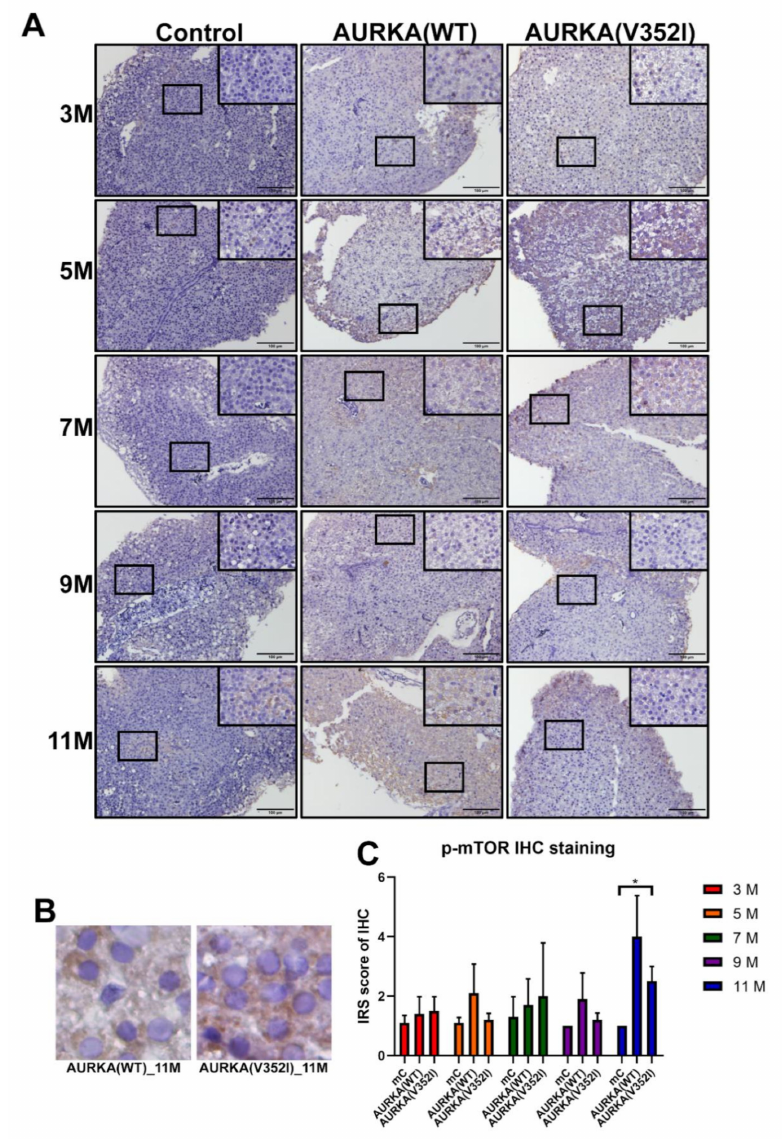
Figure 11. Immunoreactive score of phospho- mammalian target of the rapamycin (mTOR) (at Ser2448, inactive form) immunostaining for the AKT / mTOR pathway reveals that the expression of mTOR has no significant difference between control and AURKA transgenic fish. ( A ) Representative images of p-mTOR staining for PTEN in control, AURKA(WT), and AURKA(V352I) at 3, 5, 7, 9, and 11 months; ( B ) Selected enlarged images show the p-mTOR signals from AURKA(WT)—11 M and AURKA(V352I)—11 M; ( C ) Statistical analysis of p-mTOR immunostaining IRS score at 3, 5, 7, 9, and 11 months. IRS score of control fish (Tg(fabp10a:EGFP-mCherry) abbreviated as mC, AURKA(WT) and AURKA(V352I) is shown in red (3 M), orange (5 M), green (7 M), purple (9 M), and blue (11 M). Statistical analysis of results was performed using a two-tailed Student’s t -test. The error bar means standard deviation. Asterisks (*) represent the level of significance. * p -value ≤